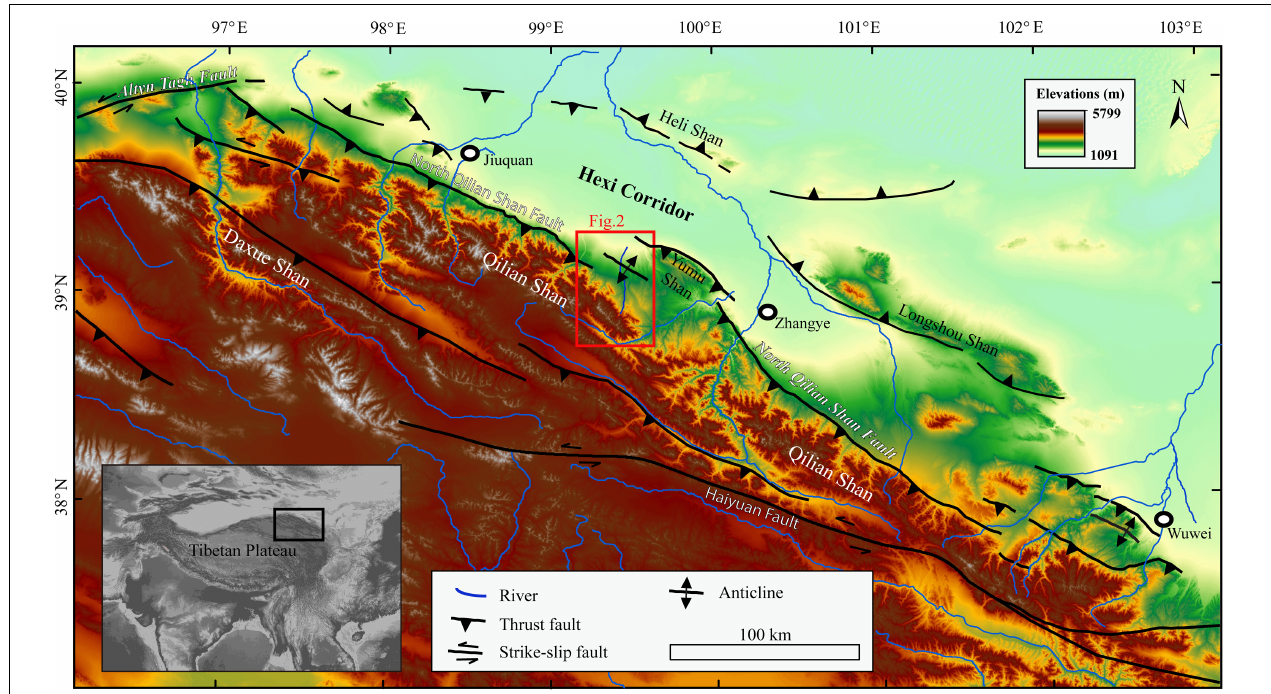
FIGURE 1 | Topographic map of the Qilian Shan [derived from the Shuttle Radar Topography Mission (SRTM) digital elevation model with 90 m resolution] and the distributions of active faults. Fault data are from Meyer et al. (1998), Hetzel et al. (2002), Yuan et al. (2013), Zheng et al. (2013), and Hu et al. (2017).